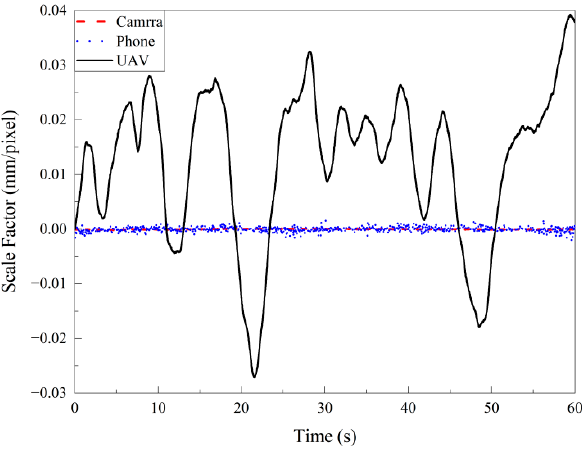
Figure 8. Comparison of adaptive scale factors of different devices.